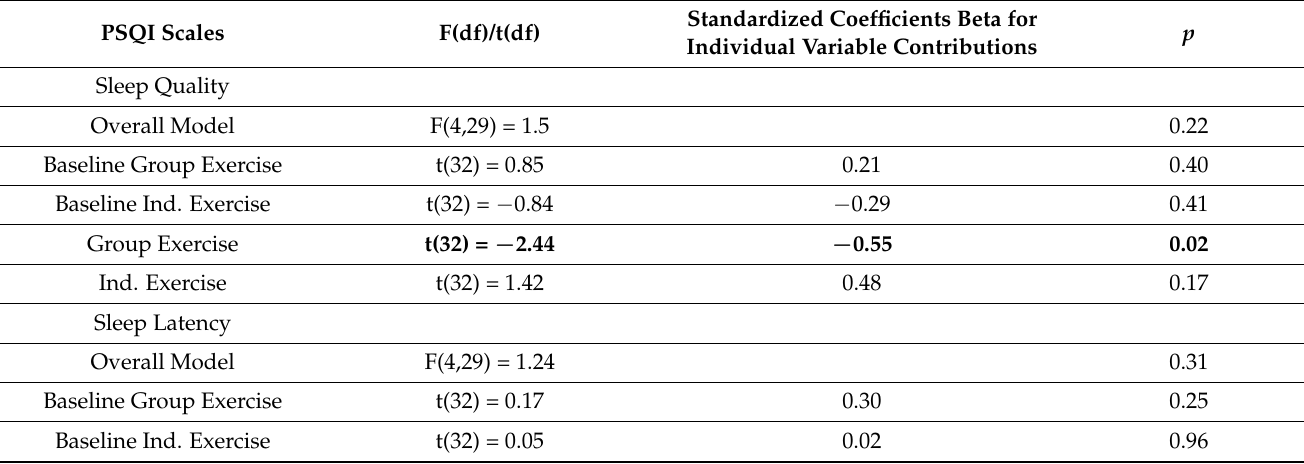
Table 2. Final Model of the Prediction of Change in PSQI Sleep Quality from Baseline to Six Months by Exercise using Linear Multiple